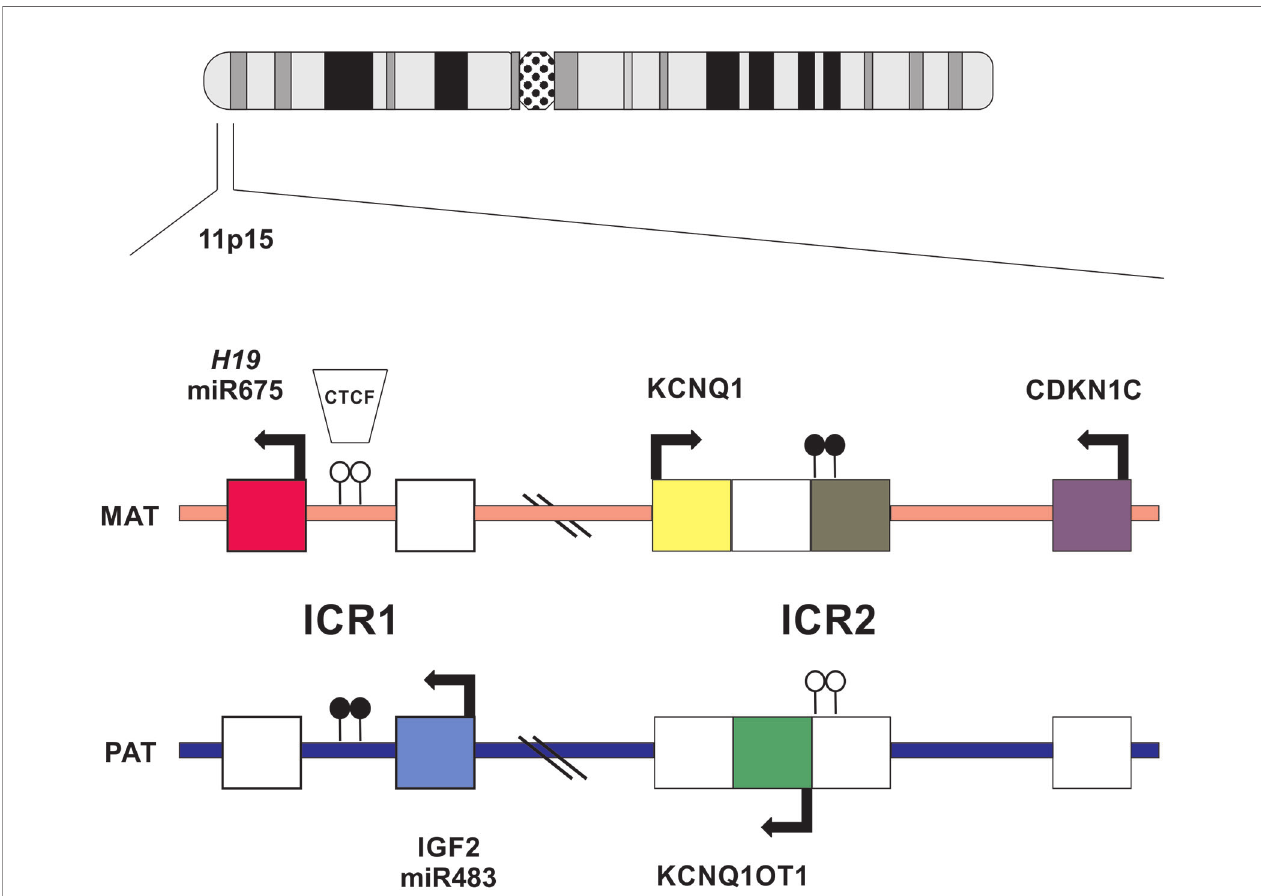
FIGURE 1 | Schematic representation of imprinted gene cluster on chromosome 11p15. Genes and their directions of transcription are shown. Maternally or paternally expressed genes are indicated by fi lled squares. Open circles show the location on normally unmethylated ICR and fi lled circles indicate normally methylated